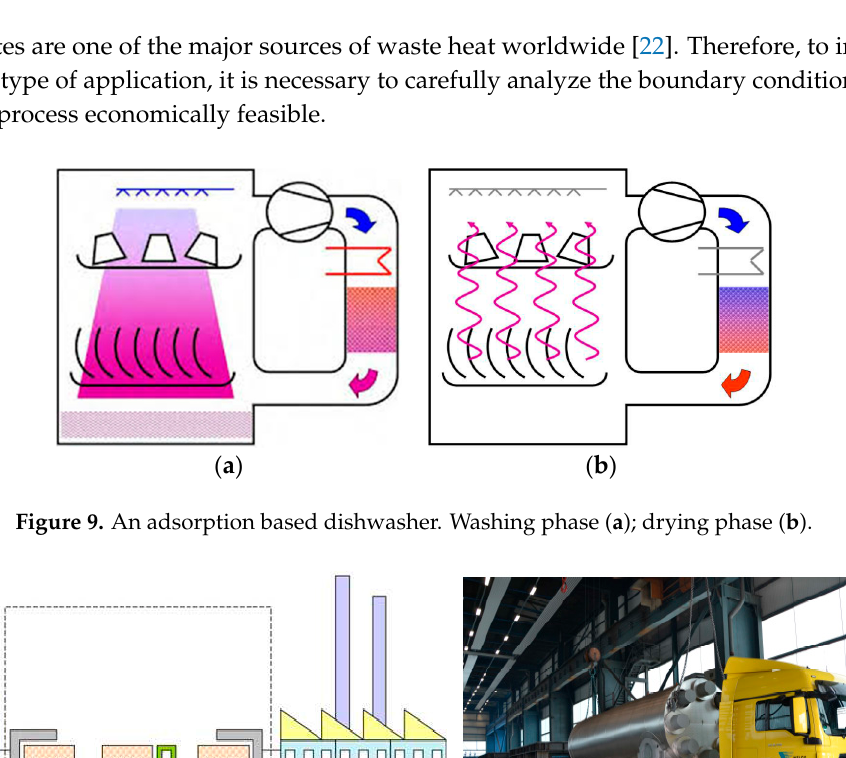
Figure 10. Mobile adsorption TES for industrial applications.